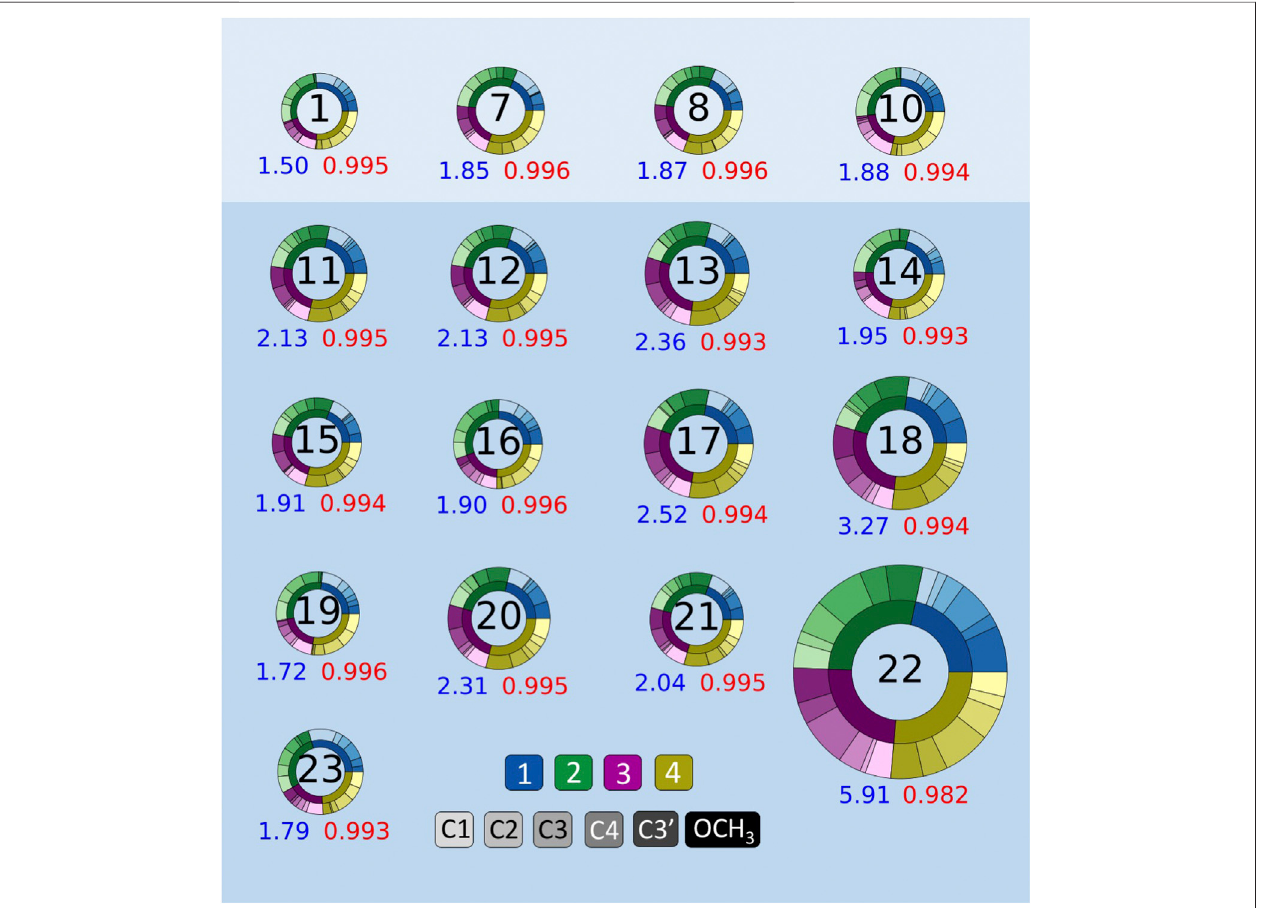
FIGURE5| Meanabsoluteerrors(MAEs, blue )inpartspermillionand r 2 values( red )for 13 Cnuclearmagneticresonance(NMR)predictions. NMRfunctional – basis sets (FBS) 11 – 23 are compared tothe top-performing methods from NMR FBS 1 – 10, shown at the top (1, 7, 8,and 10). Donut plots forall NMR FBS 1-23 areshown in Supplementary Figure S2